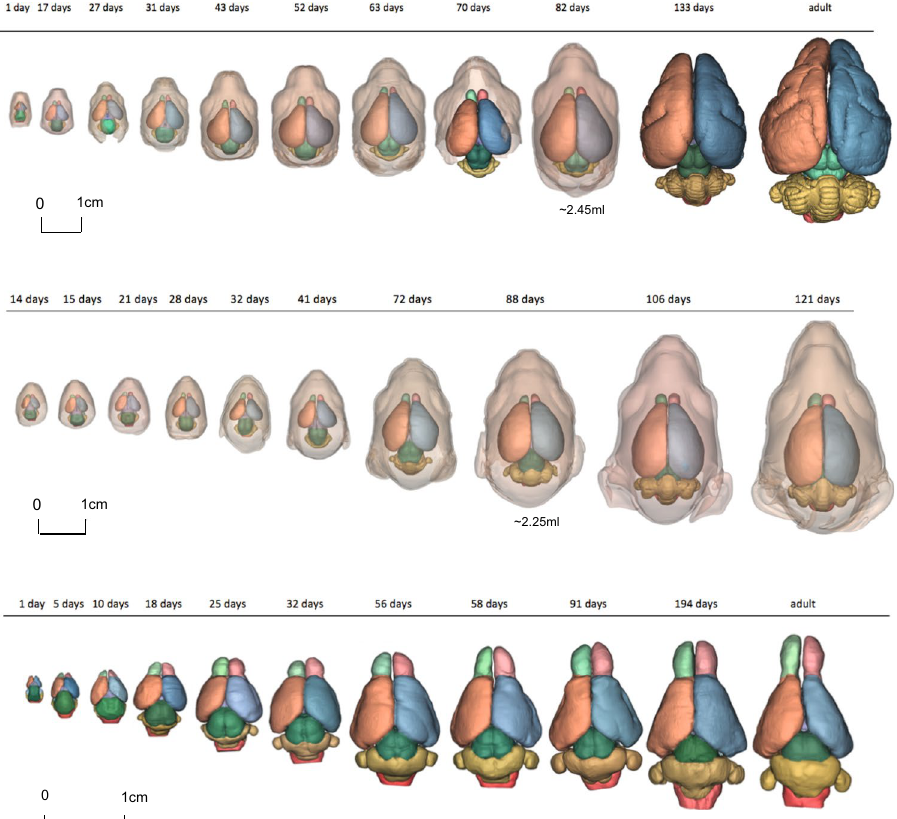
Figure 3. Chart of 3D-reconstructed dissected brains and, where available, head outlines used in this study. Green/light red, the two olfactory bulbs; orange/blue, cerebral hemispheres; dark green, midbrain; yellow, cerebellum; cherry red, medulla.